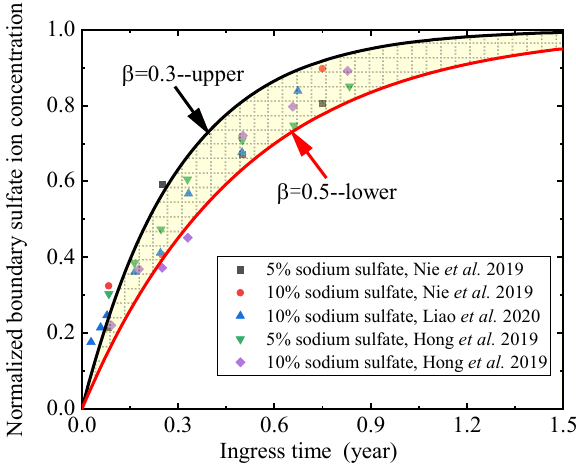
Figure 4. Profiles of boundary sulfate ion concentration.